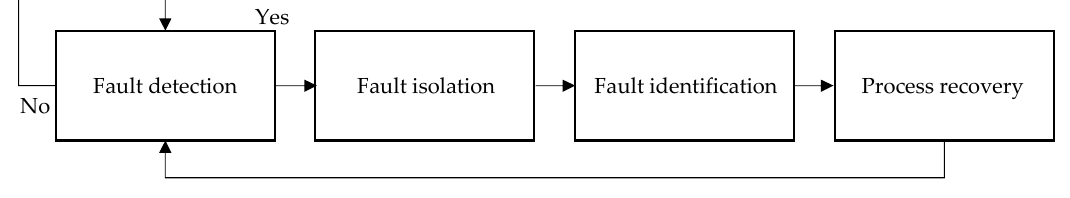
Figure 1. Implementation procedure of a conventional process monitoring.